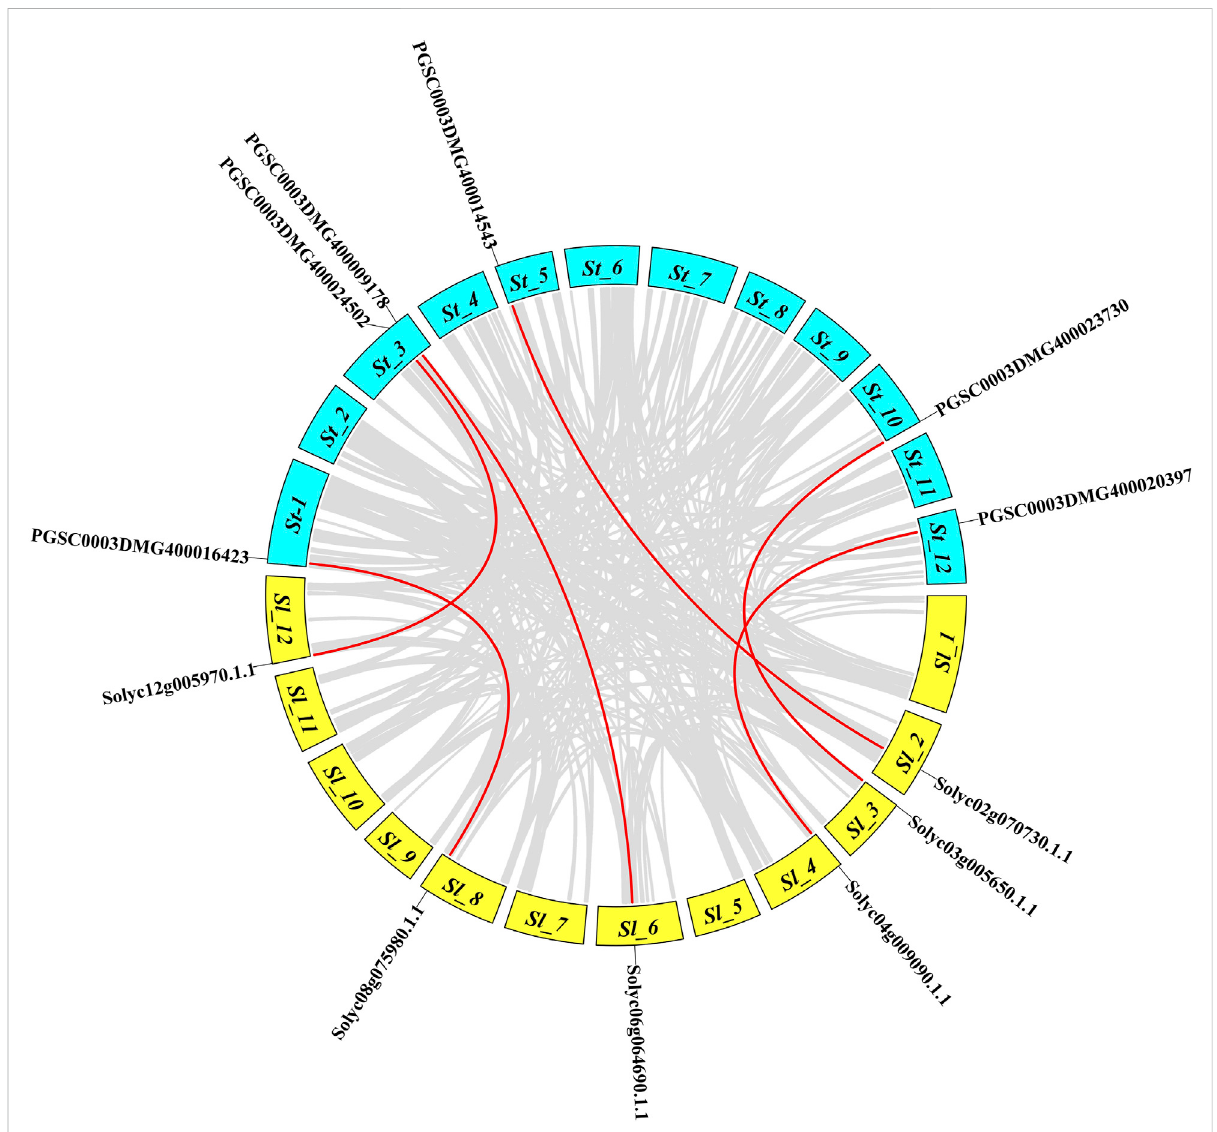
FIGURE 5 Synteny analysis of the tomato NLR gene family compared to potato. The genes on different circular bar blocks indicate their chromosomal positions, while the red lines represent duplicated genes that diverged between the